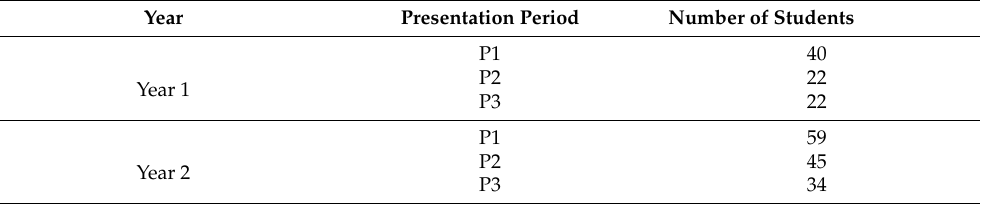
Table 3. Number of observations from each